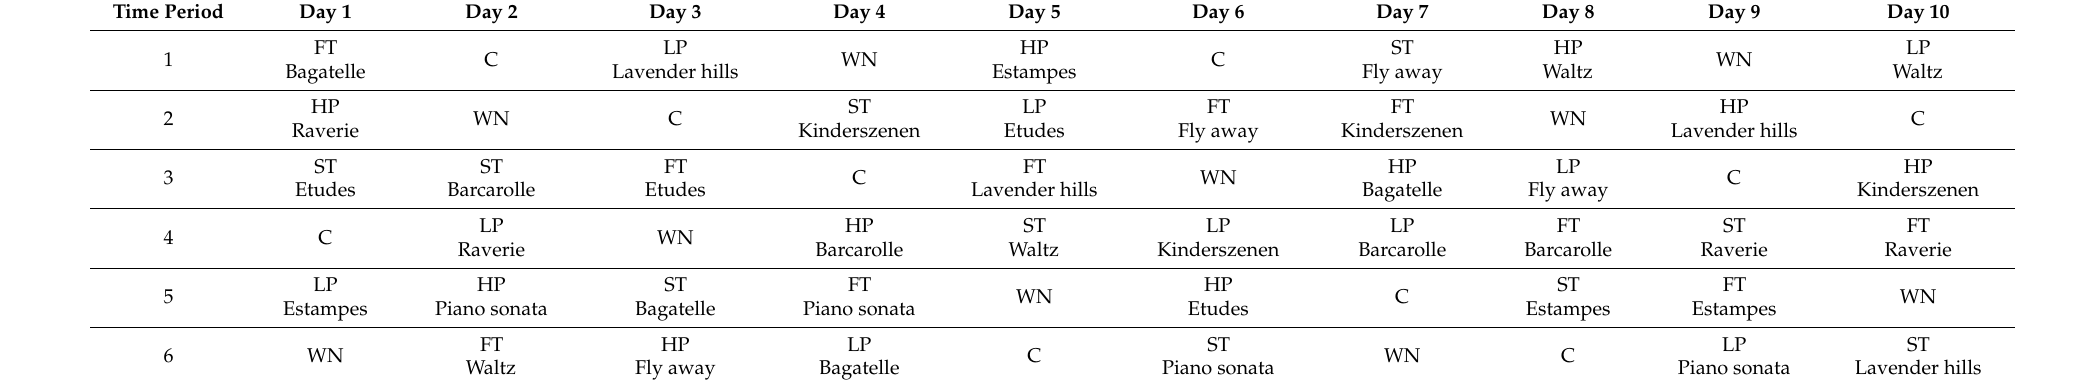
Table 1. Song and treatment combinations played to kennelled dogs ( n = 10) throughout the 10 days of study. Time period (600 s) corresponds to the order of presentation throughout the